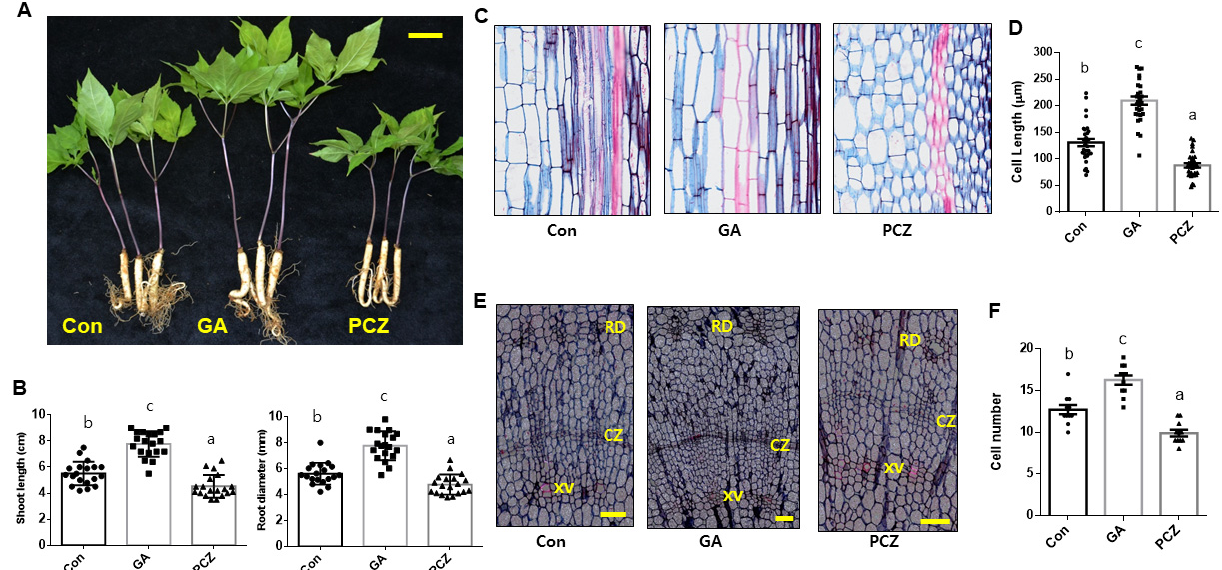
Figure 1. Exogenous gibberellin (GA) treatment promotes primary growth of stems and secondary growth of roots in Panax ginseng . ( A ) Phenotype of 1-year-old P. ginseng plants treated with DMSO (control [Con]), 10 µ M GA 3 , and 100 µ M paclobutrazol (PCZ) once a week for 8 weeks. Scale bar = 2 cm. ( B ) Measurements of shoot length and root diameter. ( C ) Representative images of stained stem cross-sections of P. ginseng plants treated with DMSO (Con), GA 3 and PCZ. Scale bar = 100 µ m. ( D ) Quantification of cell length in the indicated treatments. ( E ) Representative images of stained root cross-sections of P. ginseng plants treated with DMSO (Con), GA 3 , and PCZ. XV: xylem vessel, CZ: cambial cell layer zone, RD: resin duct cells. Scale bar = 100 µ m ( F ) Quantification of cambium-derived cells in the XV and RD of each ray. In ( B , D , F ), dots, squares and triangles represent individual values. Error bars represent standard error; n = 16 ( B ), 20 ( D ), 10 ( F ). Different lowercase letters indicate statistically significant differences ( p < 0.05; one-way analysis of variance [ANOVA], followed by Tukey’s multiple range test).